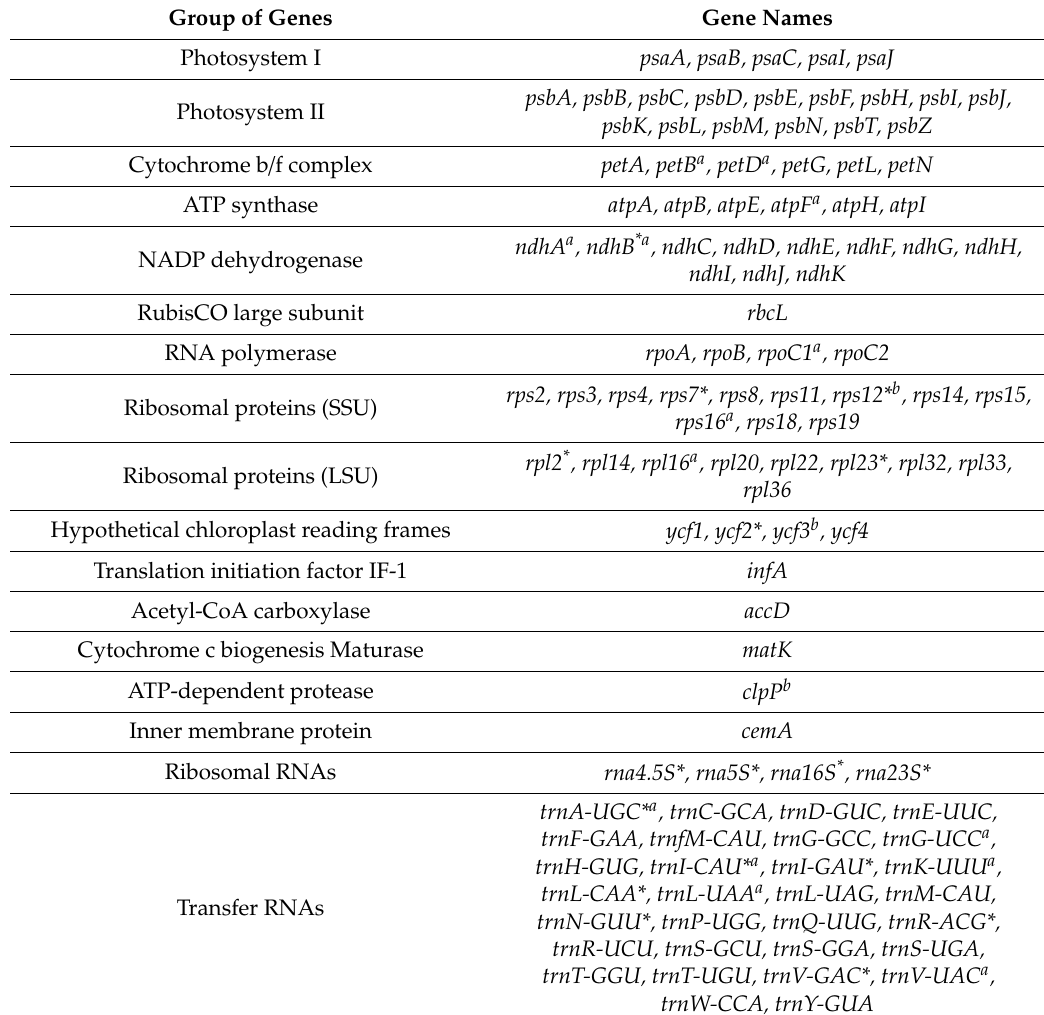
Table 1. The groups of genes within the P. granatum chloroplast genome. Group of